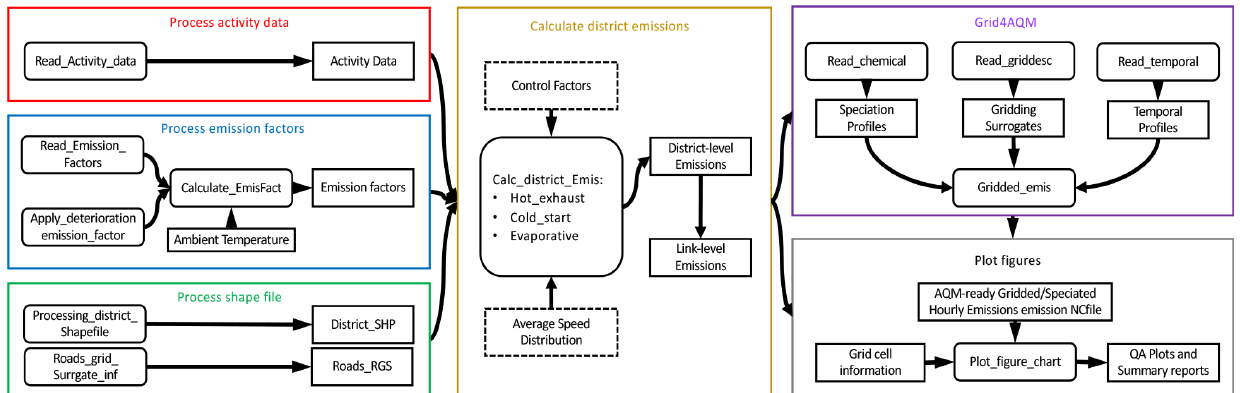
Figure 5. The schematic of modules and their functions in the